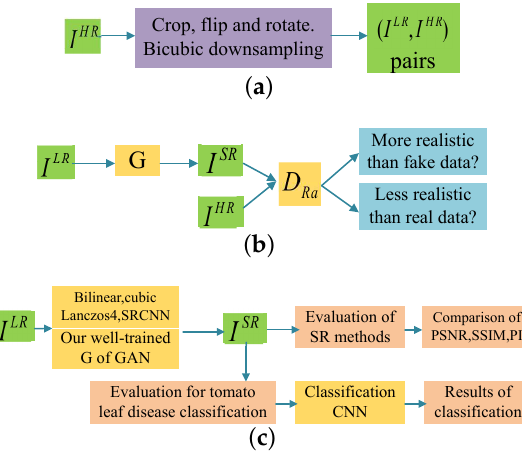
Figure 1. The three steps of our work. ( a – c ) represent the process of data processing, Generative Adversarial Network (GAN) model training and model evaluation, respectively.